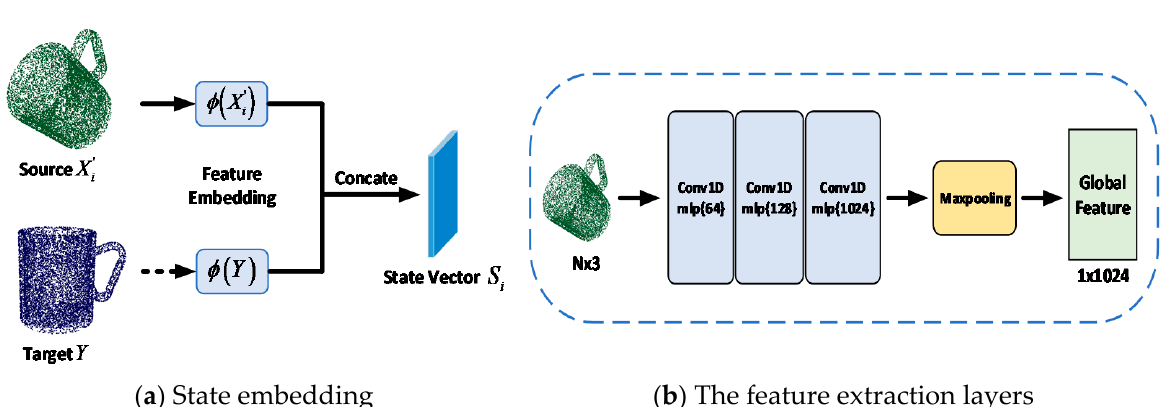
Figure 2. The architecture of feature embedding in ReAgent.